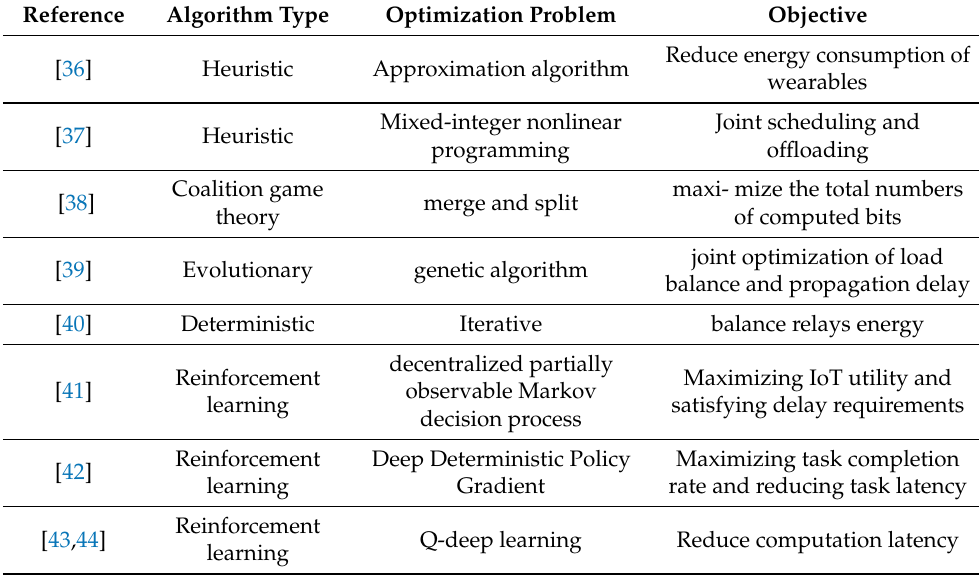
Table 2. Recently proposed offloading